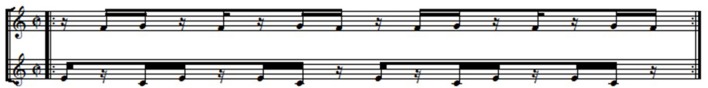
Score used in the Musical Duet Task. The upper musical line is participant A's part, the lower musical line is participant B's part.